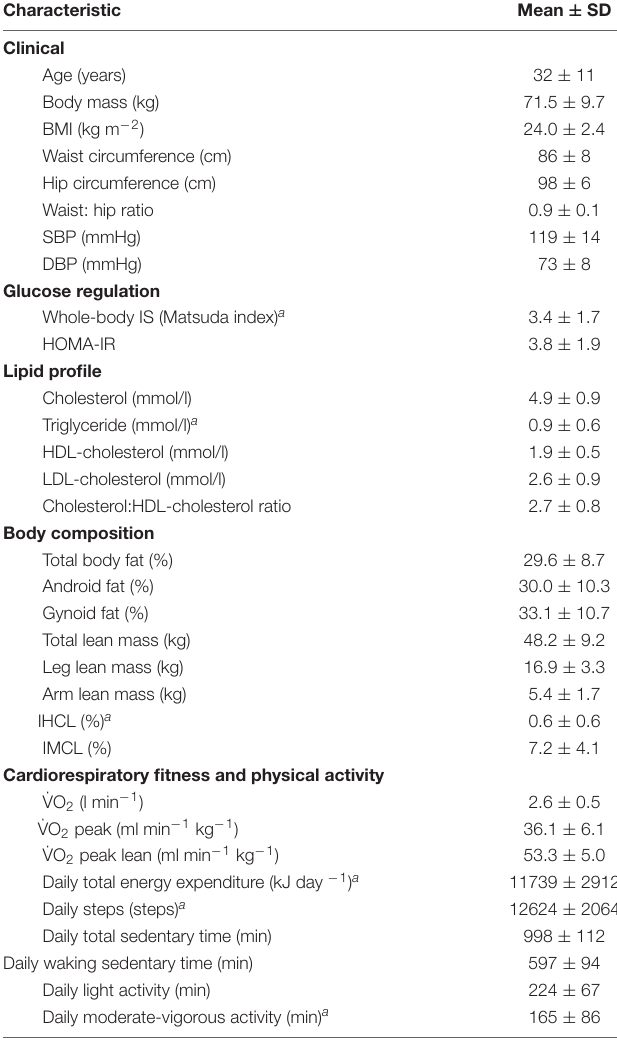
TABLE 1 | Participant characteristics at